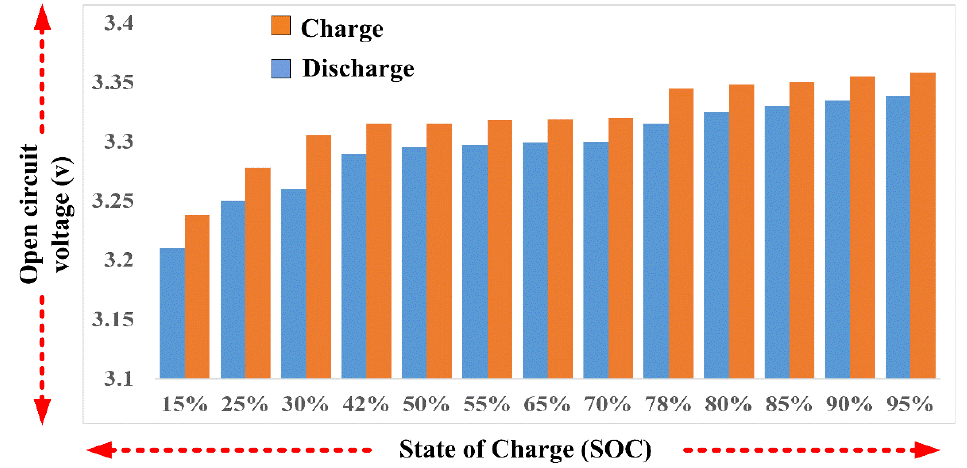
Figure 8. OCV vs. SOC was tested at 25 °C.